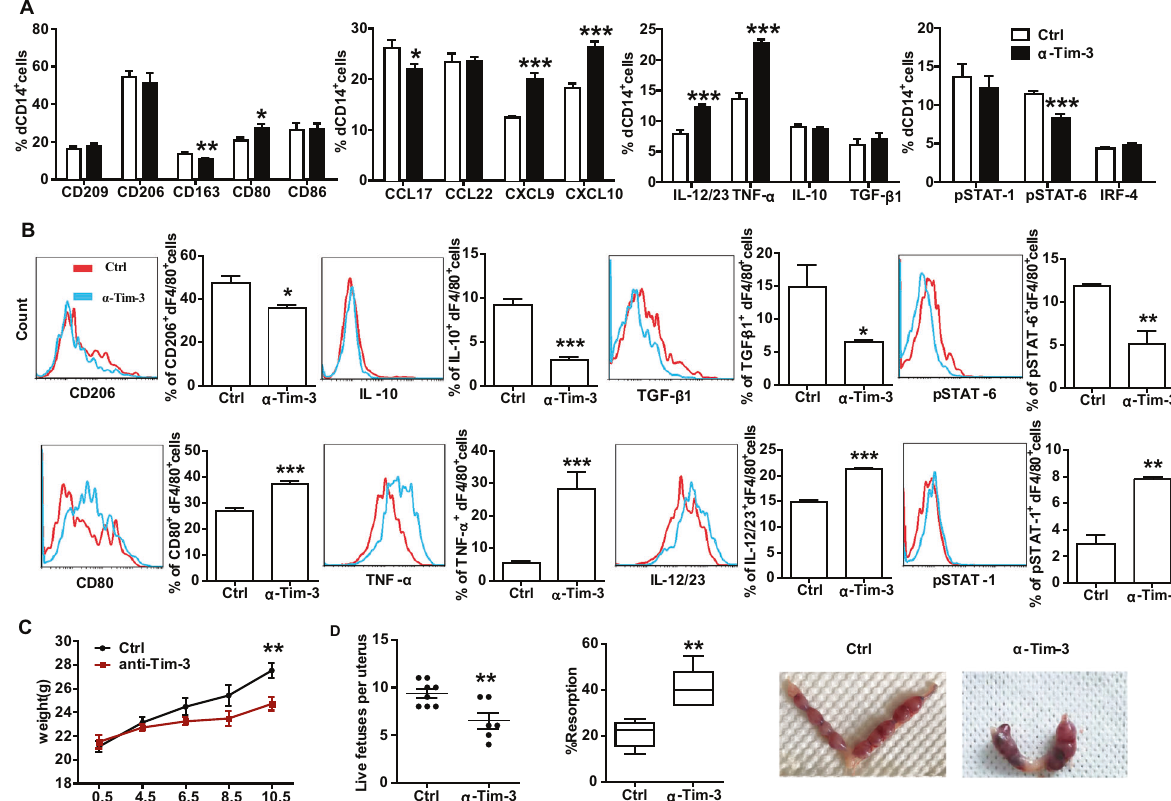
Fig. 3 Blockade of Tim-3 led to dM φ s dysfunction and murine fetal loss. A Quanti fi cation of fl ow cytometric analysis of surface molecule, cytokine and transcription factor expression by human dCD14 + cells cultured for 48 h in the presence or absence of anti-Tim-3 antibody (10 μ g/ml). Data represent the mean ± SEM. n = 9. * P < 0.05, ** P < 0.01, *** P < 0.001, compared with the control group. B Flow cytometric analysis and quanti fi cation of frequency of surface molecule, cytokine and transcription factor expression by dF4/80 + cells from pregnant CBA/J females following treatment with isotype IgG or anti-Tim-3 antibody i.p. at doses of 500, 250, and 250 mg at days 4.5, 6.5, and 8.5, respectively. C The weight of pregnant CBA/J females treated with isotype IgG or anti-Tim-3 antibody. D The number of live fetuses per uterus, the percent of fetal resorption and the representative images of uterus from pregnant CBA/J females treated with isotype IgG or anti-Tim-3 antibody. Data represent the mean ± SEM of n = 5 – 7 mice per group and are representative of three independent analyses. ** p < 0.01, compared with the control